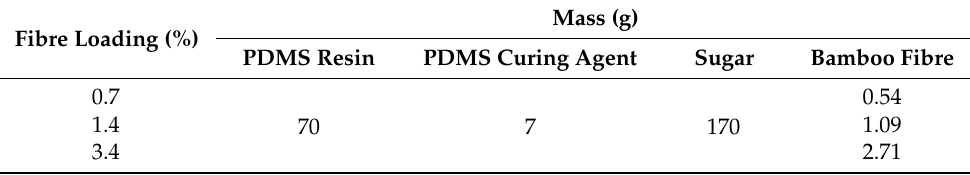
Table 1. Mass of components for bamboo fiber-polydimethylsiloxane (BF-PDMS) of various fiber loadings. Fibre Loading